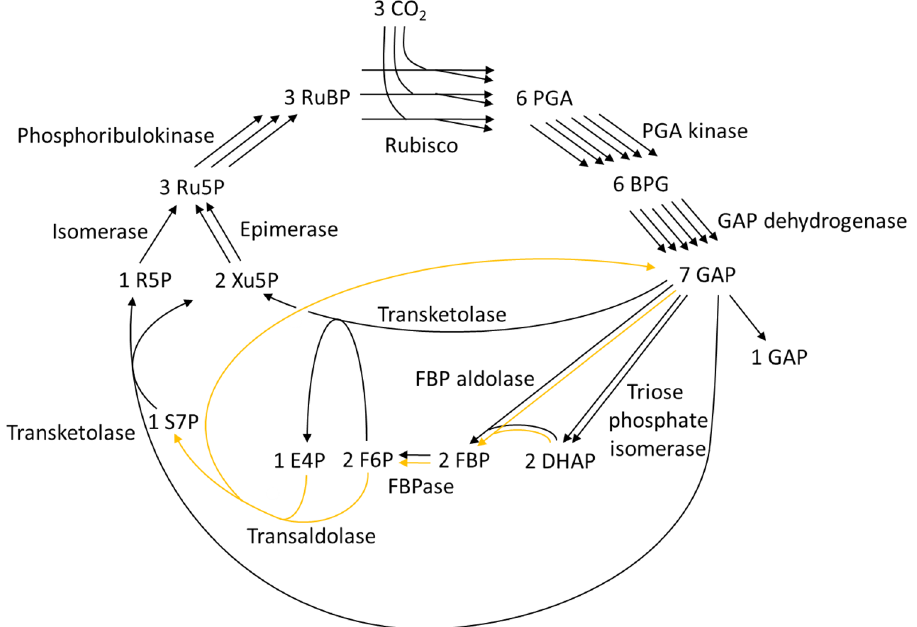
Figure 3. GAP formation from CO 2 through the S7P-forming transaldolase variant of the Calvin–Benson cycle. The reactions corresponding to the orange arrows appear in neither the S7P-removing transaldolase variant nor the canonical Calvin–Benson cycle. For abbreviations, the meaning of the numbers before each metabolite, and currency metabolites, please see the legend in Fig. 1. In this paper, the FBP and SBP formation reactions catalyzed by aldolase are named FBP aldolase and SBP aldolase,